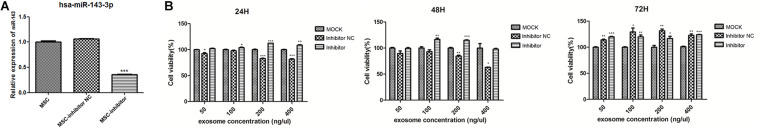
Verification data for the hsa-miR-143 inhibitor. (A) Quantitative polymerase chain reaction (qPCR) results of hsa-miR143-3P; (B) Results of Cell Counting Kit-8 (CCK-8) experiments at 24, 48, and 72 h. **p < 0.01 and ***p < 0.001 compare to the MOCK group. MOCK: CFPAC-1 only (without MSC exosome); Inhibitor NC: CFPAC-1 + MSC-hsa-miR-143-3p inhibitor negative control; Inhibitor: CFPAC-1 + MSC-miR-143 inhibitor group.